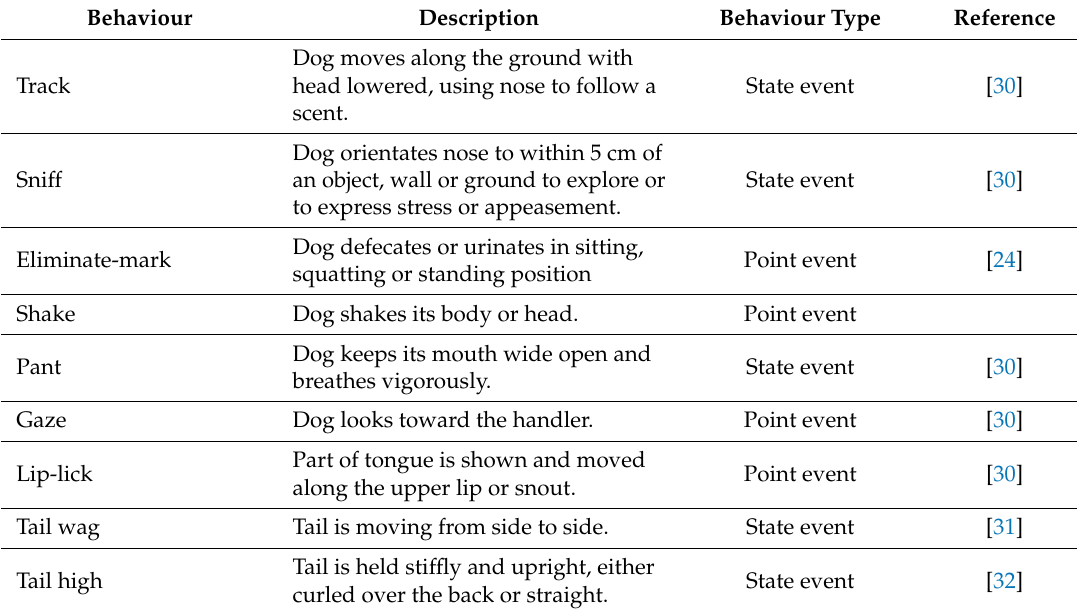
Table 3. Ethogram of canine behaviour.